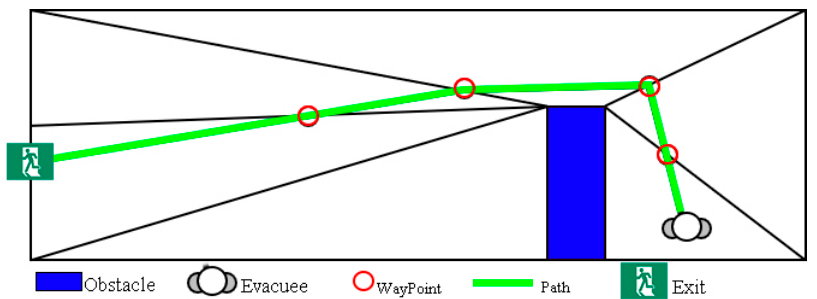
Figure 1. Path generation in A* search algorithm.